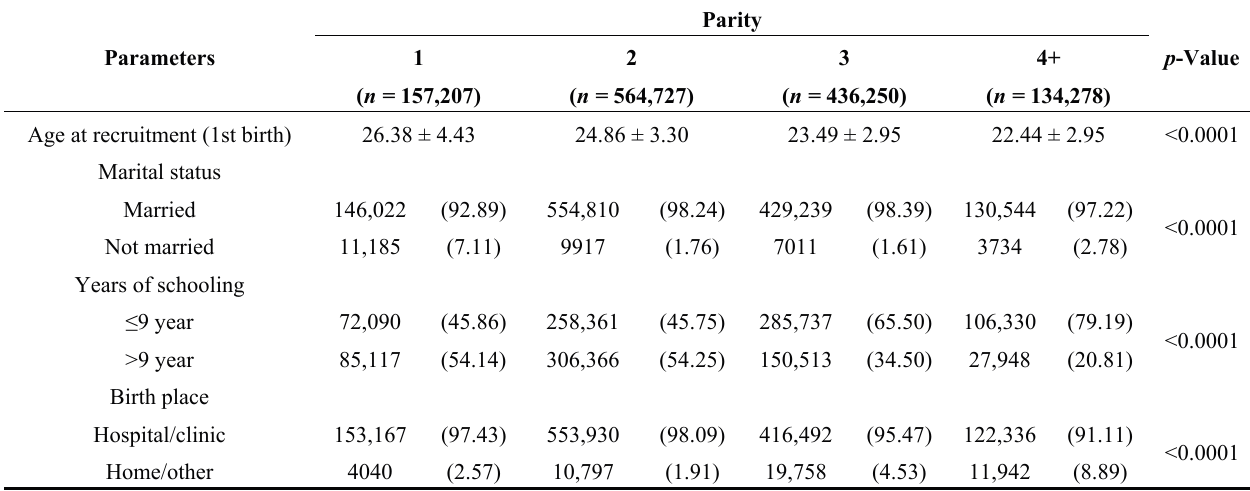
Table 1. Demographic characteristics of the study cohort.